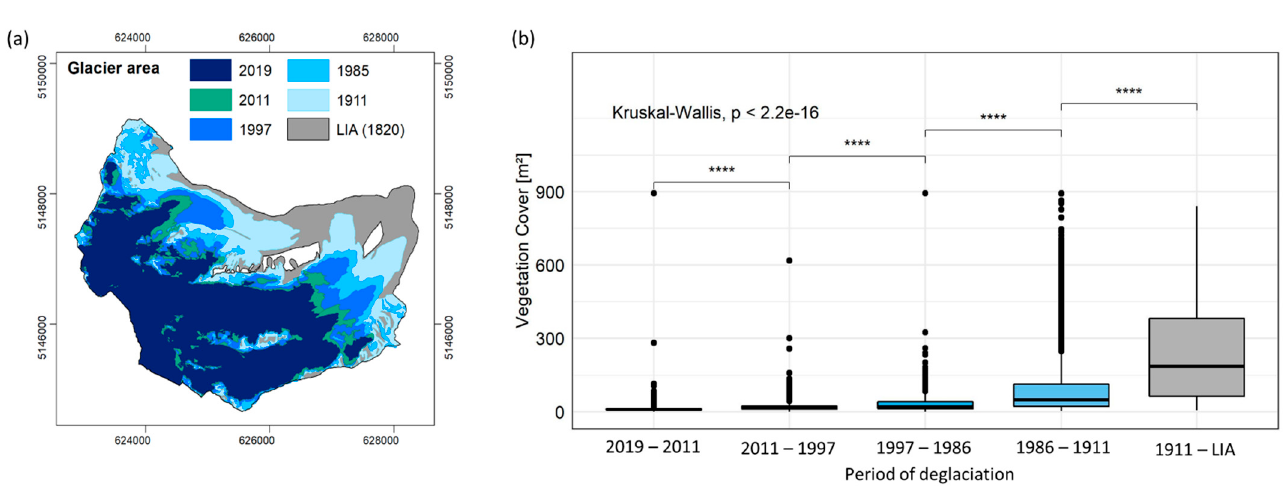
Figure 6. Relationship between glacier retreat and vegetation cover. The ( a ) area-wide glacier development led to a constant enlargement of the proglacial area. The ( b ) statistical relation between the vegetation cover per Landsat pixel [m 2 ] of the year 2019 were tested in dependency of the development of proglacial area (**** p < 0.0001). The pixels were categorized according to the interval of deglaciation. Source of glacier data : ~1820/End of LIA: Own mapping of the lateral moraines in the field and from the ALS -Hillshade (2019), 1911: Map of the 4th Federal survey, 1985: DGM and Orthophoto (Autonomous Province of Bozen/Bolzano, South Tyrol), 1997: Glacier Inventory South Tyrol; Hydrological Office (Autonomous Province of Bozen/Bolzano, South Tyrol), 2011 and 2019: Own mapping based on ALS -data (see Section 2.2.3). Table 5. Proglacial area and area with vegetation cover, analyzed for the different plant communities and four observation periods, expressed as (a) glacier area (km 2 ), total area covered with vegetation (km 2 ) and the standard error (b) percentage change of the area in comparison to the preceding period.